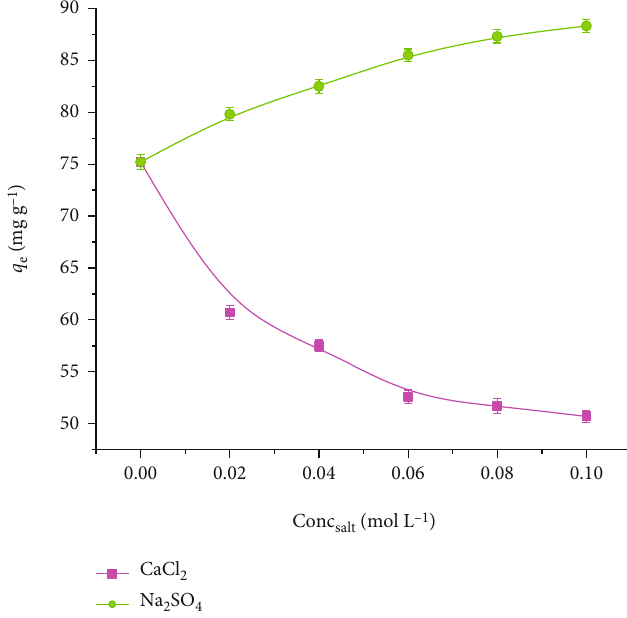
= 100 mgL -1 , V = 10 mL, m = 0 : 01 g, 0